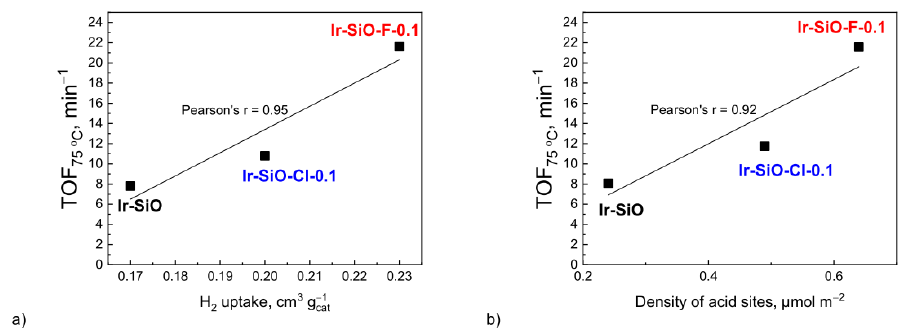
Figure 10. Turnover frequency (TOF) at 75 °C in toluene hydrogenation reaction as a function of total hydrogen uptake ( a ) and density of acid sites ( b ) of iridium catalysts.